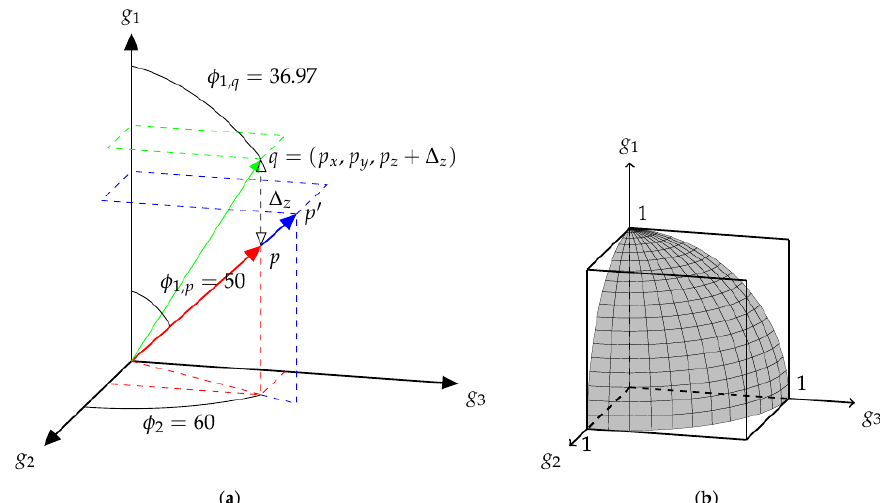
Figure 2. Graphical representation of three mixes in mix-space. While shown for three tracks, this is generalisable to any number of tracks n , using hyperspherical coordinates. (a) Mix at a point in 3-track gain space. Note that the audio output at points p and p (cid:48) is the same ‘mix’, despite the vectors having different lengths in this space; ( b ) For a 3-track mixture, while the cube ( R 3 ) represents all outputs of a summing mixer, the surface of the sphere ( S 2 ) represents all possible